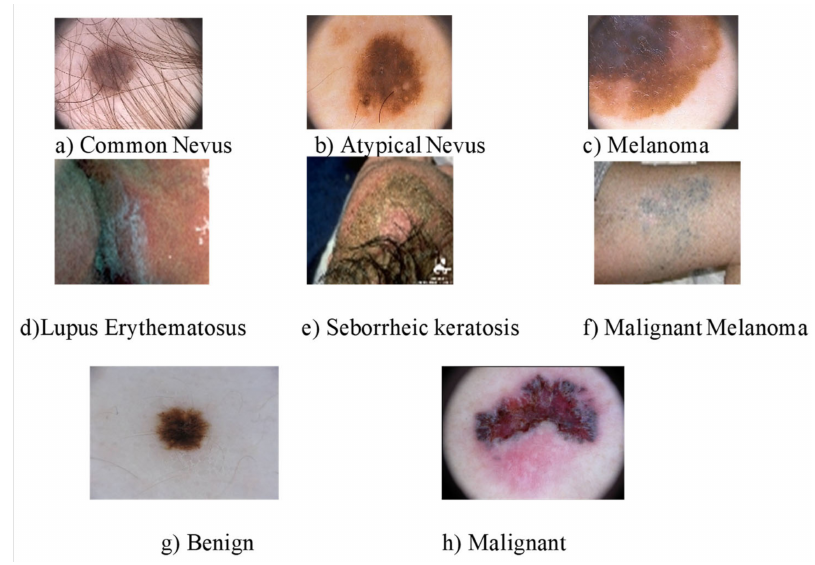
Figure 1. Samples of utilized images in different datasets.